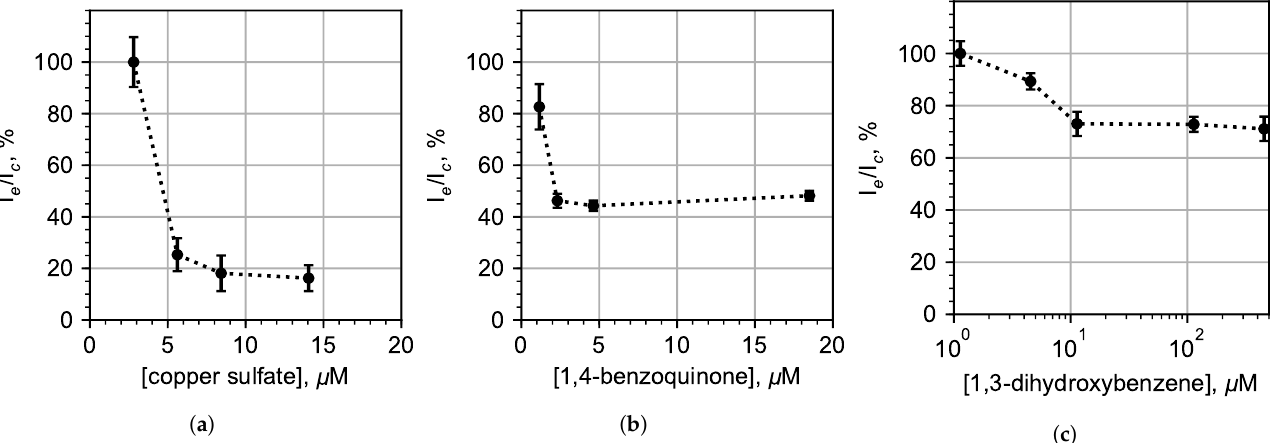
Figure 7. Luminescence intensity inhibition of the multienzyme bioluminescent system in droplets with the addition of model pollutants: ( a ) copper sulfate; ( b ) 1,4-benzoquinone; and ( c )